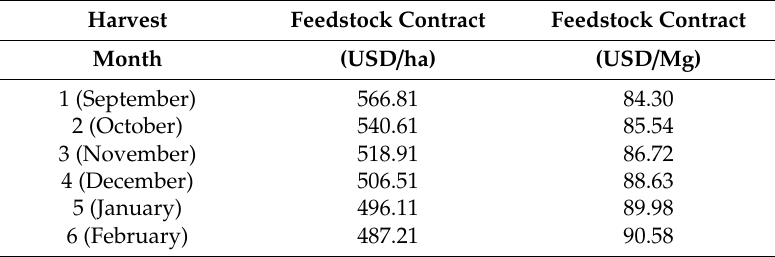
Table 11. Feedstock contract payments for biomass placed in an SSL each month, no storage loss adjustment (Scenario 2). (Results obtained with Scenario 2 MATLAB